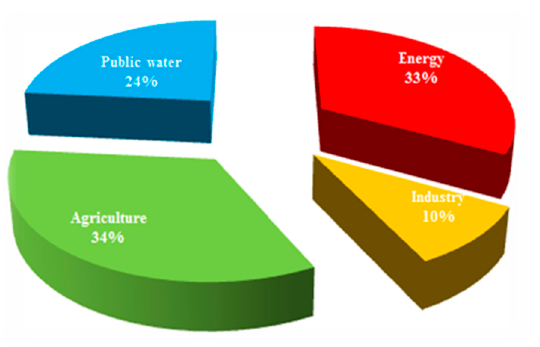
Figure 1. Water consumption in the whole of Europe, based on Eurostat data (2020). Turkey is included [2]. Table 1. Millions of cubic meters of water consumption in Europe* per year [2].